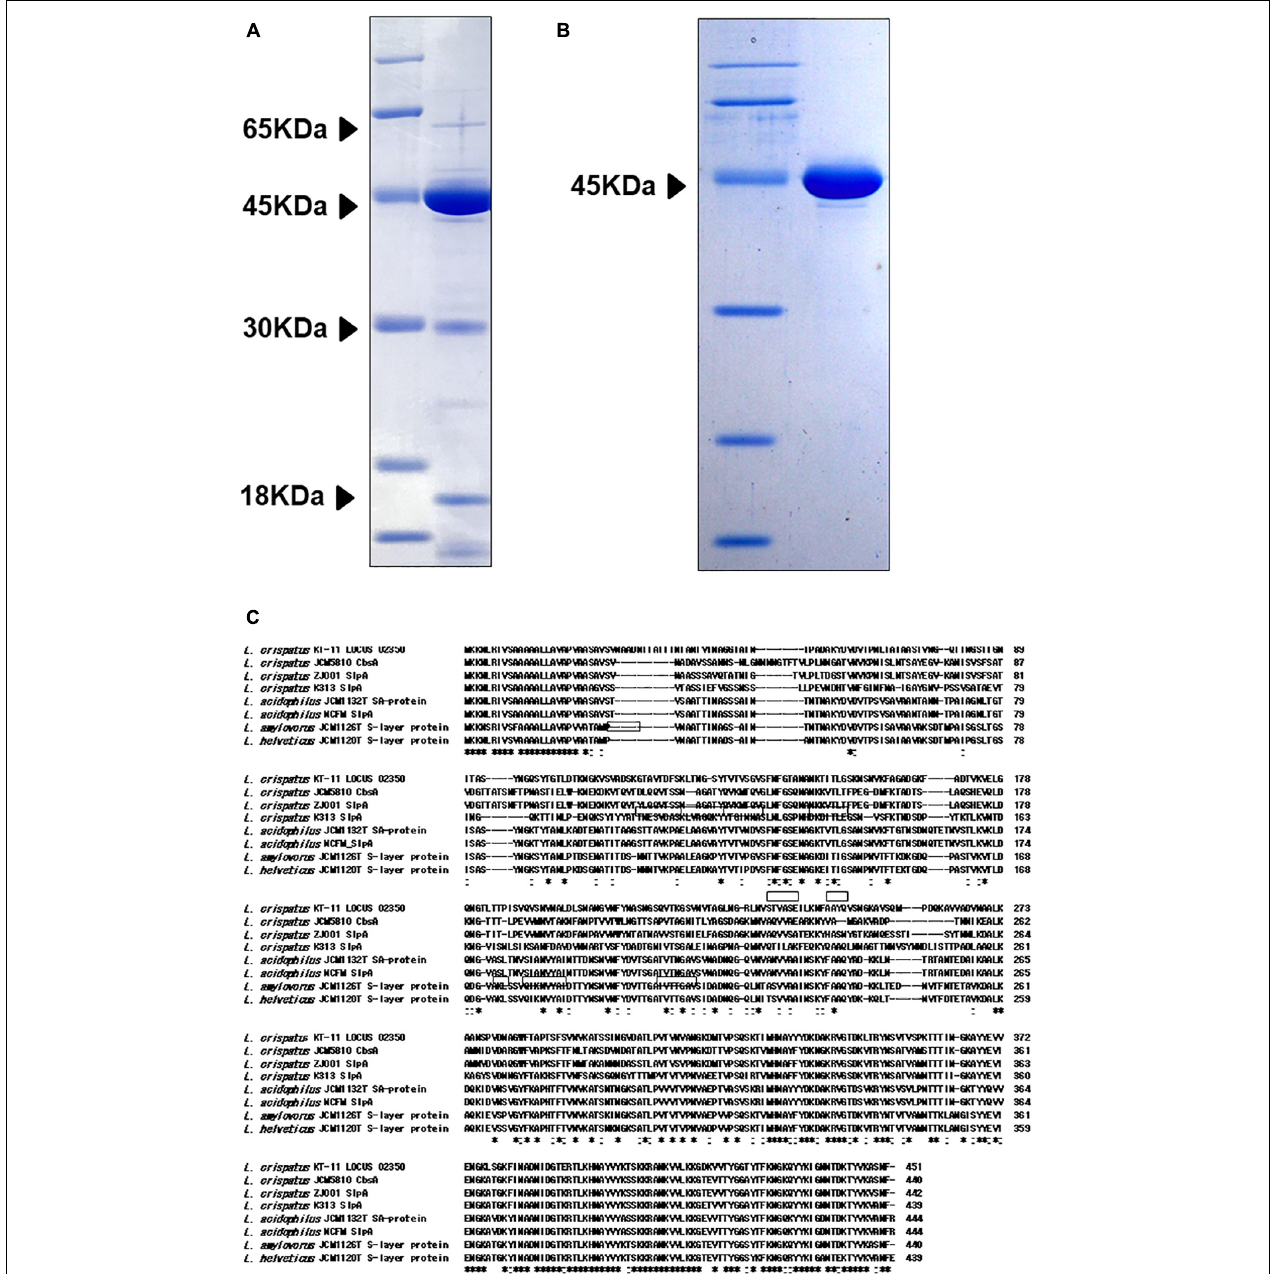
FIGURE 3 | SDS-PAGE pattern and amino acid sequence of the 45 kDa protein. SDS-PAGE patterns of (A) KT-11 LE and concentrated 45 kDa protein (B) . (C) Comparison of the revealed amino acid sequences of the 45 kDa protein and SLPs from other Lactobacillus strains. The framed areas show the amino acid sequences revealed by protein identification analysis using NanoLC-MS/MS. Hyphens indicate deletions or insertions of amino acids. “ ∗ ” denotes that the residues are identical in all sequences in the alignment, and “:” denotes that conserved substitutions are observed.